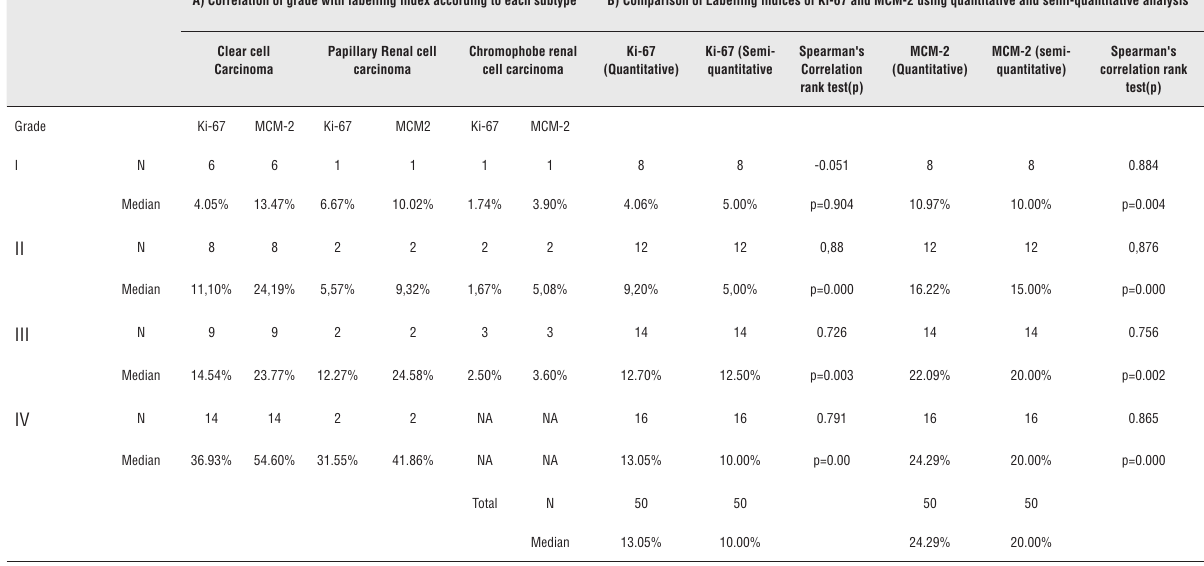
Table 2A - Breakdown of values of proliferation index according to tumour subtype and grade. There is an increase in proliferation index in clear cell renal cell carcinoma and papillary renal cell carcinoma according to grade. no such relationship is seen in the chromophobe renal tumours.Table 2B - There is remarkable correlation between quantitative and semiquantitative analysis for both markers. In group I the median value for Ki-67 is 4.05% in quantitative analysis while it is 5% in semiquantitative analysis. McM-2 shows 10.96% in quantitative and 10.00 in semiquantitative analysis. for grade II Ki-67(quantitative) is 9.2% versus 5% in semi-quantitative. McM-2 shows better correlation in this grade with median values of 16.21% versus 15%. In group III Ki- 67(quantitative) is 12.7% and semi-quantitative is 12.5%. McM-2 shows (quantitative)22.08% versus 20% in semi-quantitative analysis. finally grade Iv shows Ki-67(quantitative) 36.93% versus 40% in semiquantitative. McM-2(quantitative) 50.99% versus 55% in semiquantitative. The mean values and standard deviations also correspond with each other. note that Ki-67(semi-quantitative) median for grade I and II is same as compared to McM-2. spearman’s correlate is significant in all cases except for Ki-67 grade I.